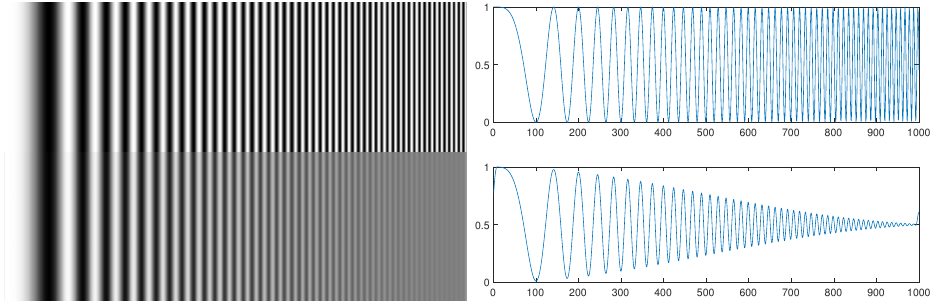
Figure 5. The basis for MTF concept: sine wave degradation as image and